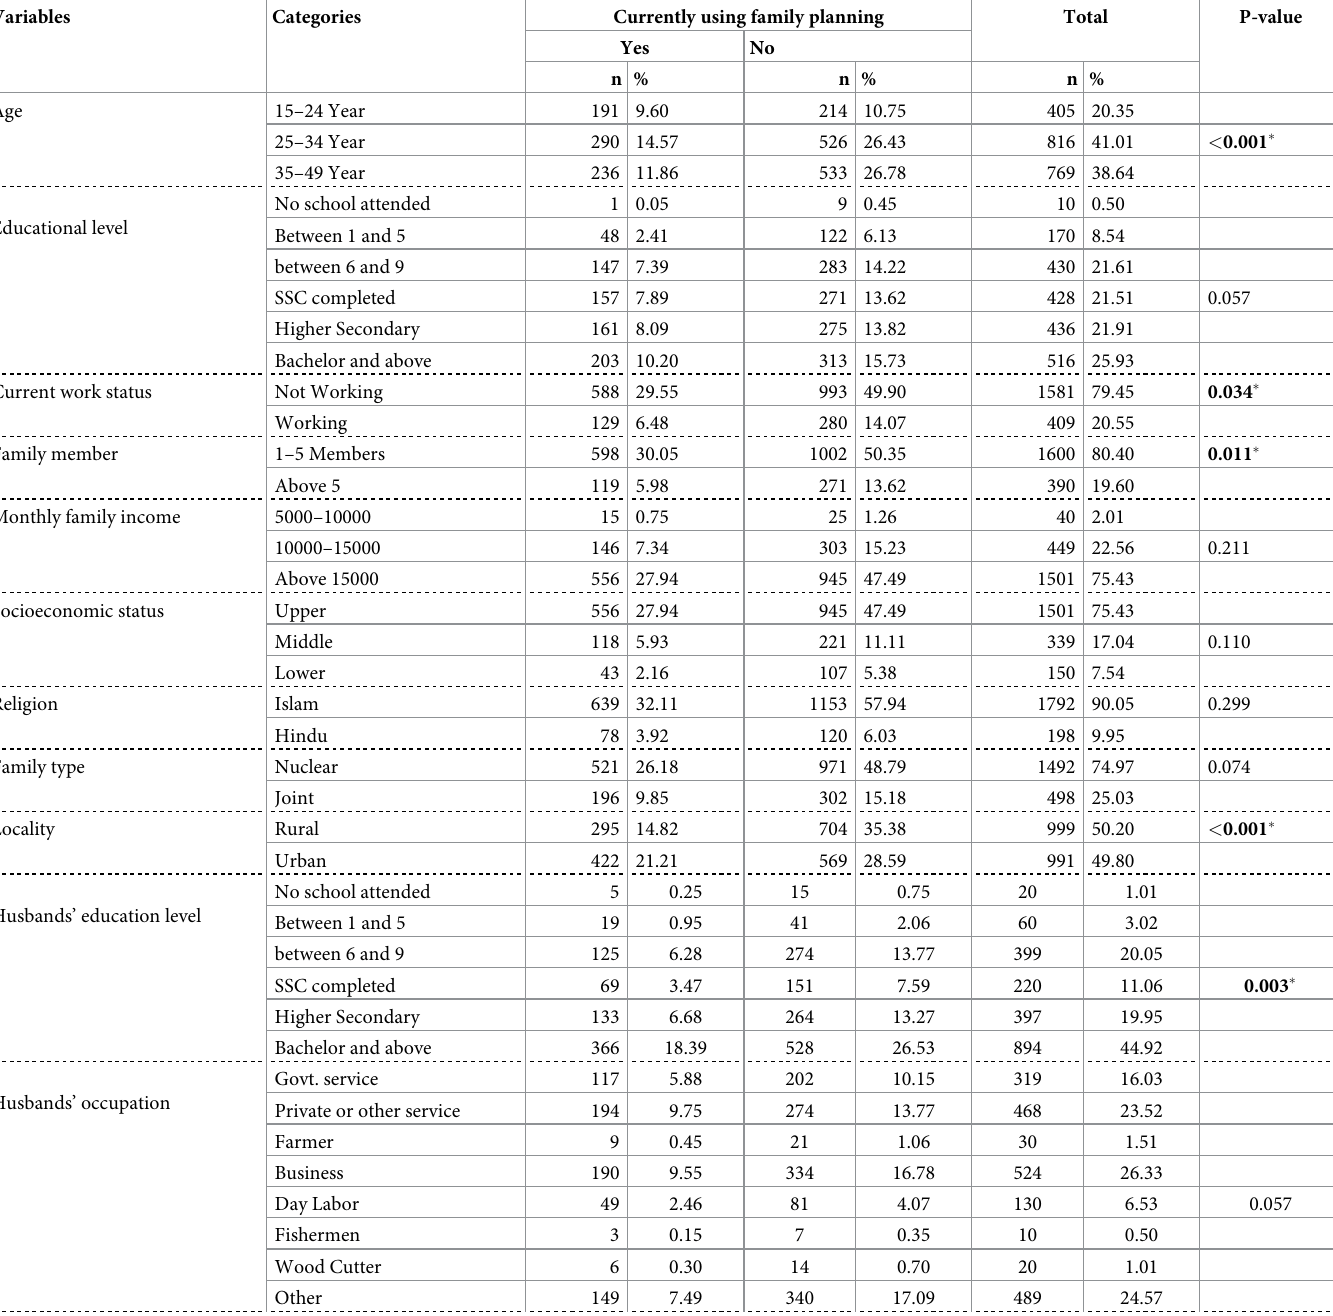
Table 1. Scio-demographic and socio-economic characteristics of the respondents.